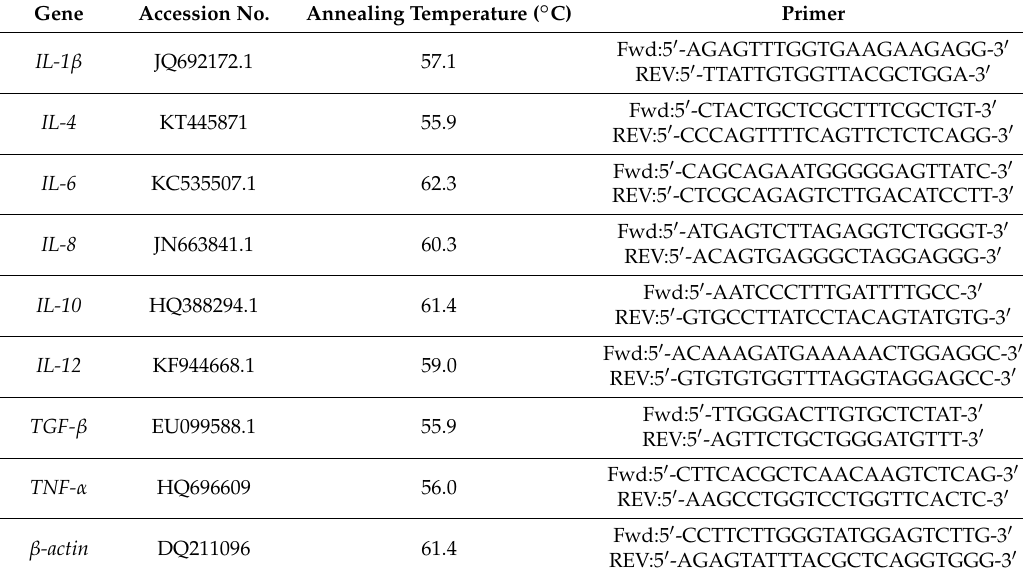
Table 3. Primers used in the